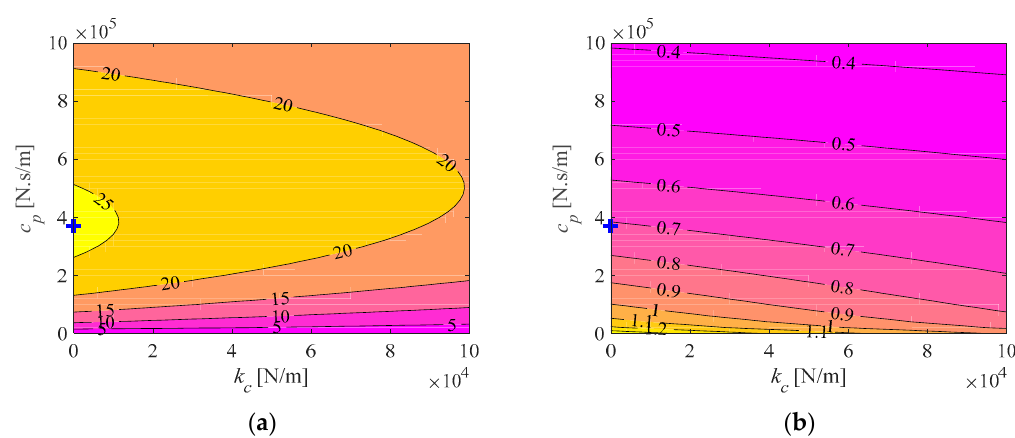
Figure 5. An example of the contour of the absorbed power P and significant motion amplitude z s as functions of the damping coefficient of the PTO system c p and external stiffness k c at the sea state of T e = 8 s, H s = 2 m for a vertical truncated cylindrical buoy with the radius-to-draft ratio of r / d = 1 and m n = 1: ( a ) Absorbed power in kW; ( b ) significant motion amplitude in m. The optimal solution is marked by a bold “+”.